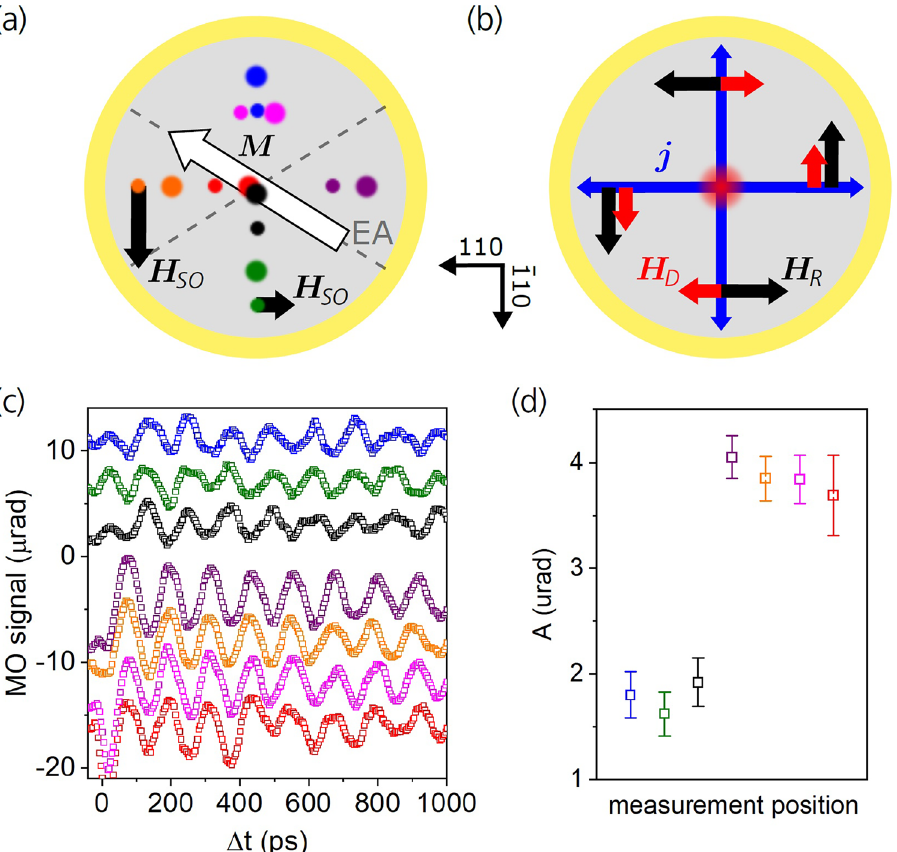
Figure 3. Anisotropy of the SOT-induced precession amplitude with respect to the photocurrent direction. ( a ) Schematic illustration of the photodiode with positions of spatially-separated pump and probe laser spots indicated by different colors. The larger and smaller dots indicate the pump and probe spot positions, respectively (with a diameter of ≈ 1 µm), which were always 9 µm apart with the probe spot displaced either along [ 110 ] or [ 110 ] crystallographic direction. The directions of the magnetization M (white arrow) and the local total spin–orbit field H SO (black arrows) are also indicated. (b) Directions of the Bychkov-Rashba ( H R , black arrows) and Dresselhaus ( H D , red arrows) contributions to the total spin–orbit field H SO for different photocurrent directions (blue arrows) in the device. Combination of the two anisotropic contributions results in different magnitudes of H SO when probing along [ 110 ] and [ 110 ] in ( a ). (c) Magnetization precession measured for applied bias of − 10 V at positions indicated in ( a ) by the corresponding colors; the curves are vertically shifted for clarity. (d) Precessional amplitude A extracted by fitting the data in part ( c ) by Eq. (1) for Δ t > 100 ps. The colors of the data points correspond to that used in parts ( a , c ). The larger magnetization precession amplitude observed for current pulses propagating along [110] direction is in agreement with the stronger H SO compared to the case of pulses propagating along [ 110 ]